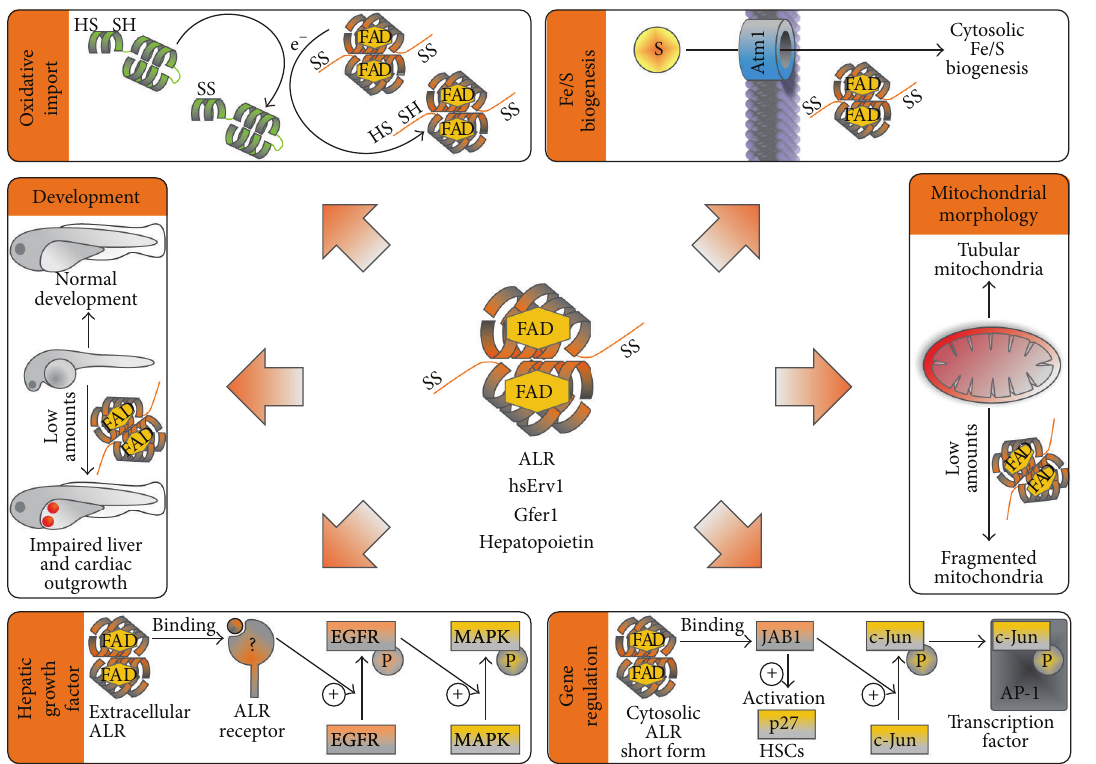
Figure 4: Functions of Erv1/ALR. Oxidative Import . Erv1/ALR reoxidizes Mia40. Fe/S Biogenesis . In yeast Erv1/ALR is required for the biogenesis of cytosolic Fe/S proteins but not for mitochondrial Fe/S proteins. Development . Erv1/ALR is expressed during development. Knockdown or chemical inhibition of Erv1/ALR leads to impaired development of organs such as liver and hamper cardiac outgrowth. Mitochondrial Morphology . Erv1/ALR is important for mitochondrial morphology in undifferentiated cells. Knockdown of Erv1/ALR in mouse embryonic stem cells leads to mitochondrial fragmentation and increased levels of Drp1 (dynamin-related protein 1). Hepatic Growth Factor . Extracellular Erv1/ALR increases regenerative capacities of liver tissue. Extracellular Erv1/ALR can bind to a so far unknown receptor. Upon binding tyrosine-phosphorylation of the epidermal growth factor receptor (EGFR) is enhanced which promotes phosphorylation and activation of mitogen activated protein kinase (MAPK). Gene Regulation . A truncated cytosolic form of Erv1/ALR can bind to Jun activating bindingprotein1(JAB1).BindingtoJAB1increasesJAB1-mediatedphosphorylationofc-Jun.Uponphosphorylationc-Juncanformacomplex with AP-1 complex (activator protein 1). In hematopoietic stem cells (HSC) sequestering of JAB1 by ALR prevents binding of JAB1 to